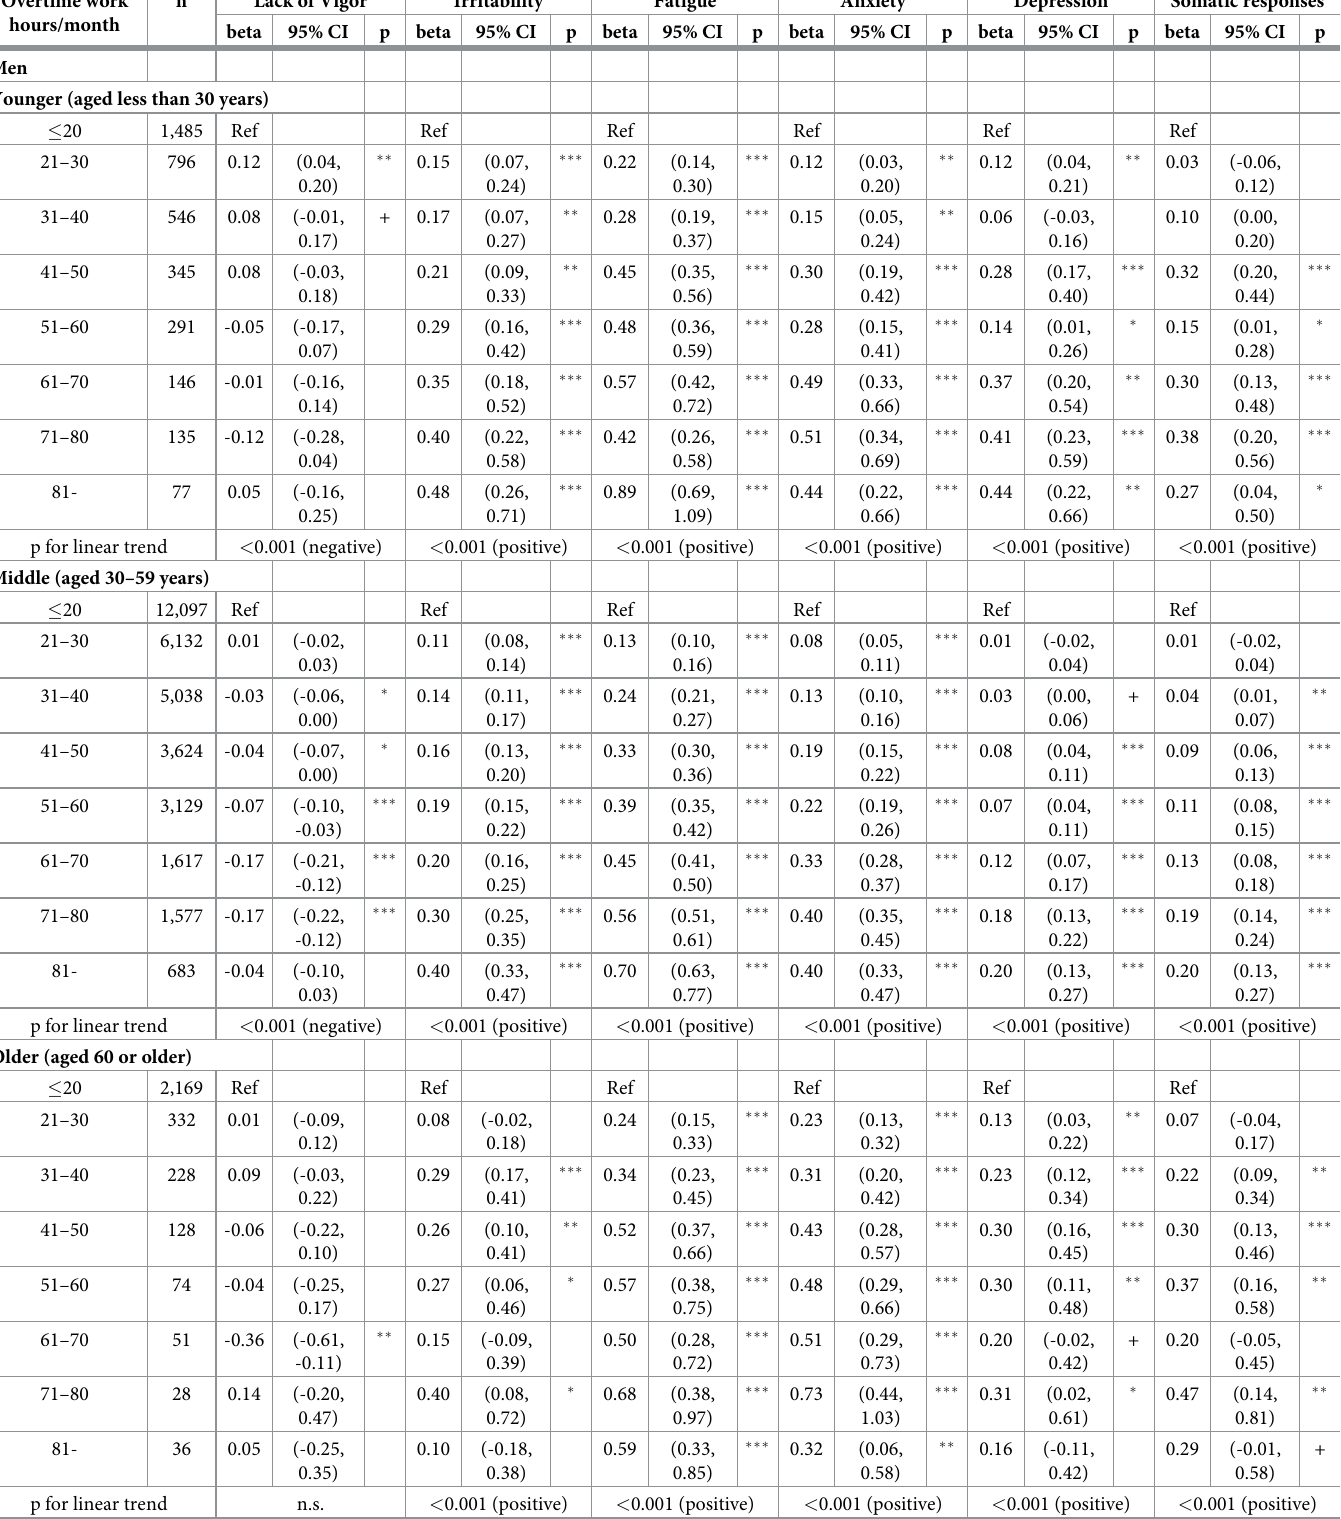
Table 3. Association between overtime work hours and stress responses: Results of multiple linear regression stratified by gender and age-category. Overtime work